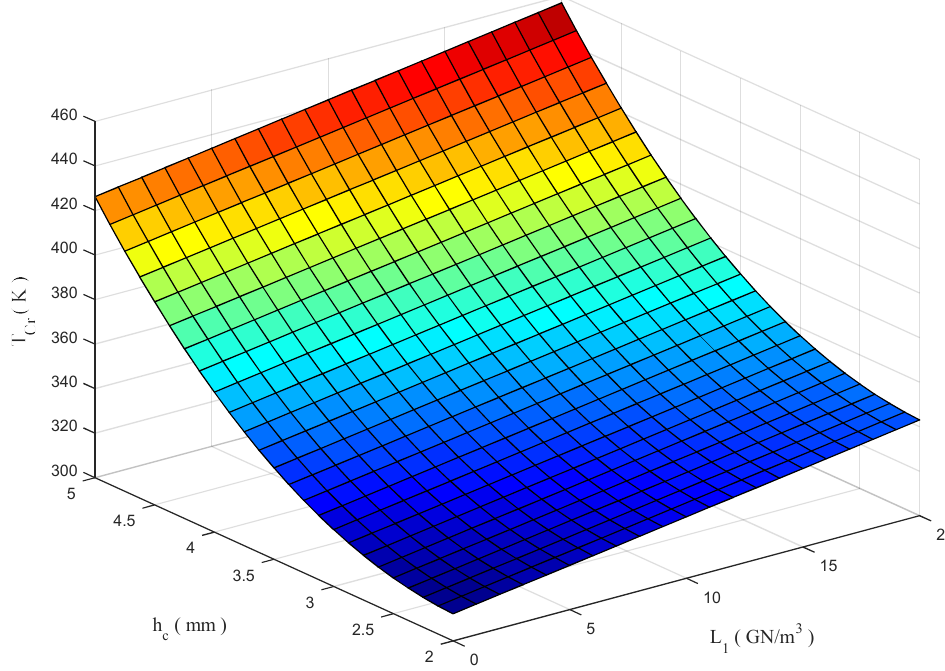
Figure 12. Double effect of core thickness and foundation spring parameter on the critical buckling temperature of a sandwich beam.